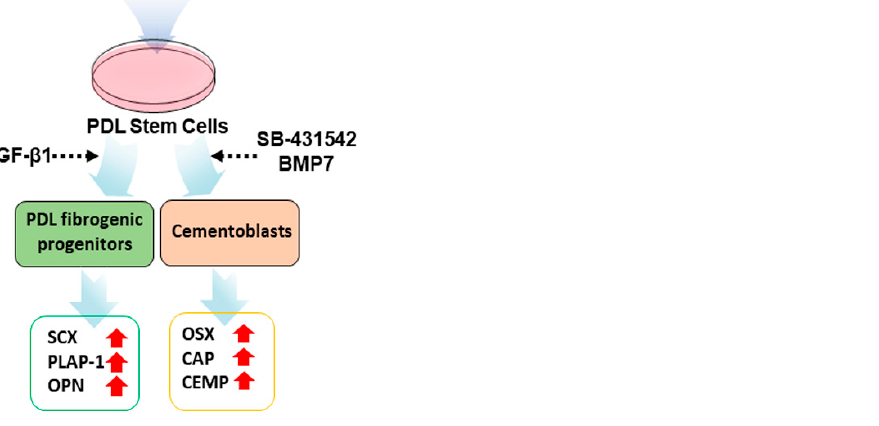
Figure 1. Schematic strategy of the cytodifferentiation of hPDLCs into ligament-fibroblastic progenitors and cementoblast-like cells. The detailed scheme of the differentiation is described in the materials and methods.